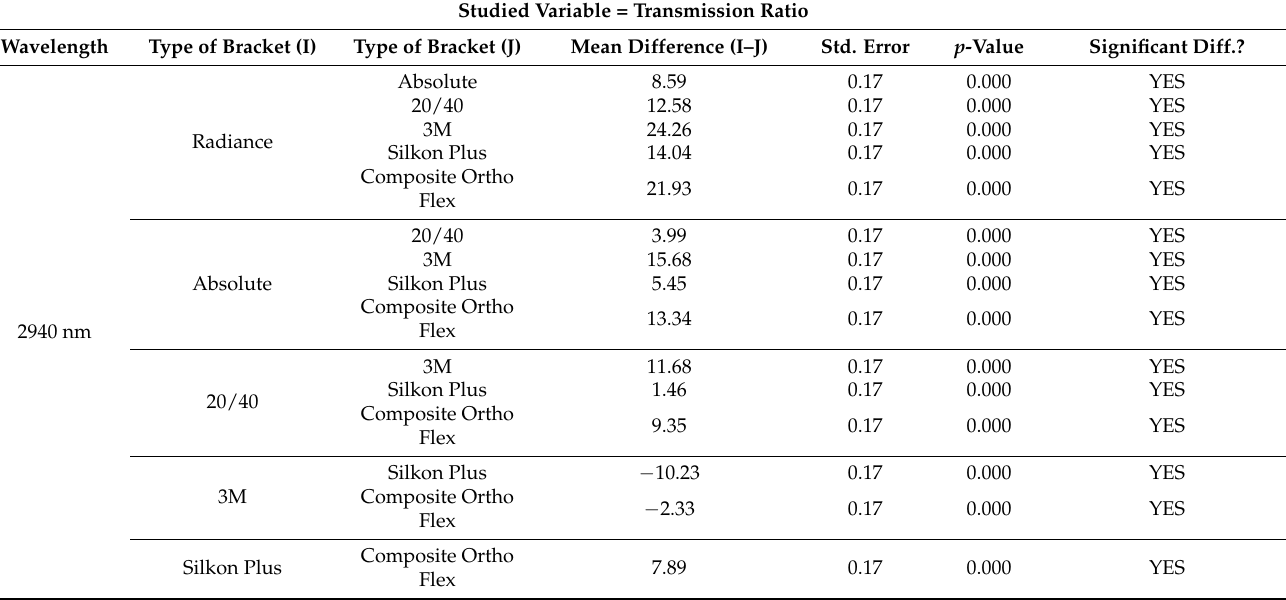
Table 4. Results of the Bonferroni post-hoc test to determine whether there were pair-wise significant differences in transmission ratio values between the different bracket groups according to